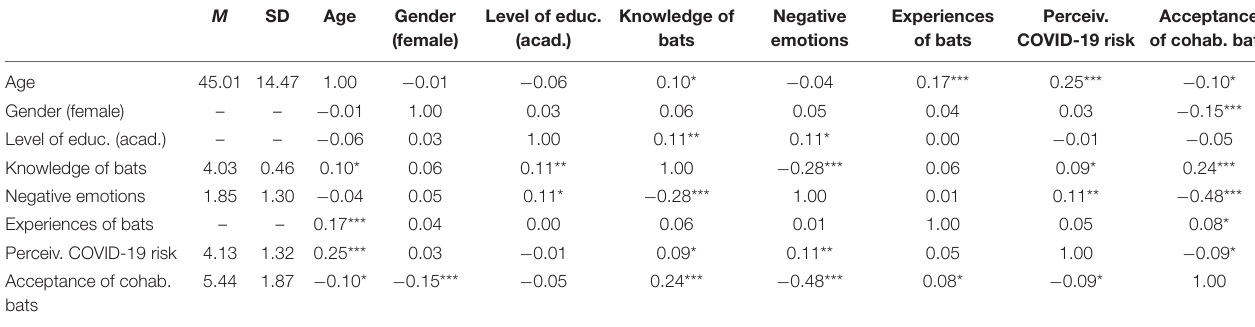
TABLE 2 | Means, standard deviations and correlations (Spearman rho).